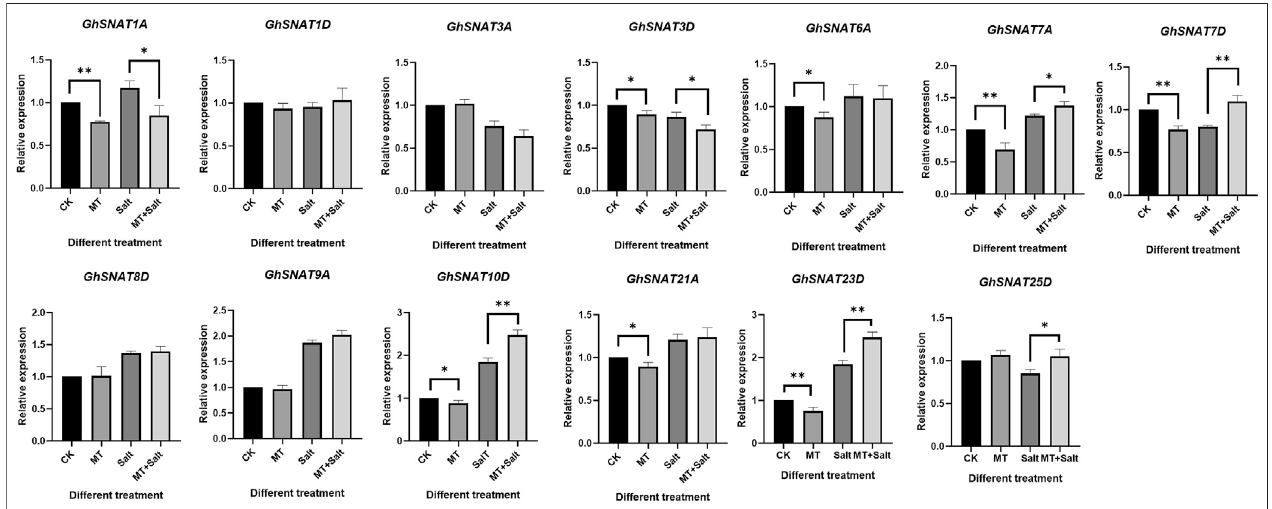
FIGURE 7 | Effect of exogenous melatonin on GhSNAT s expression. * p < 0.05 and ** p <